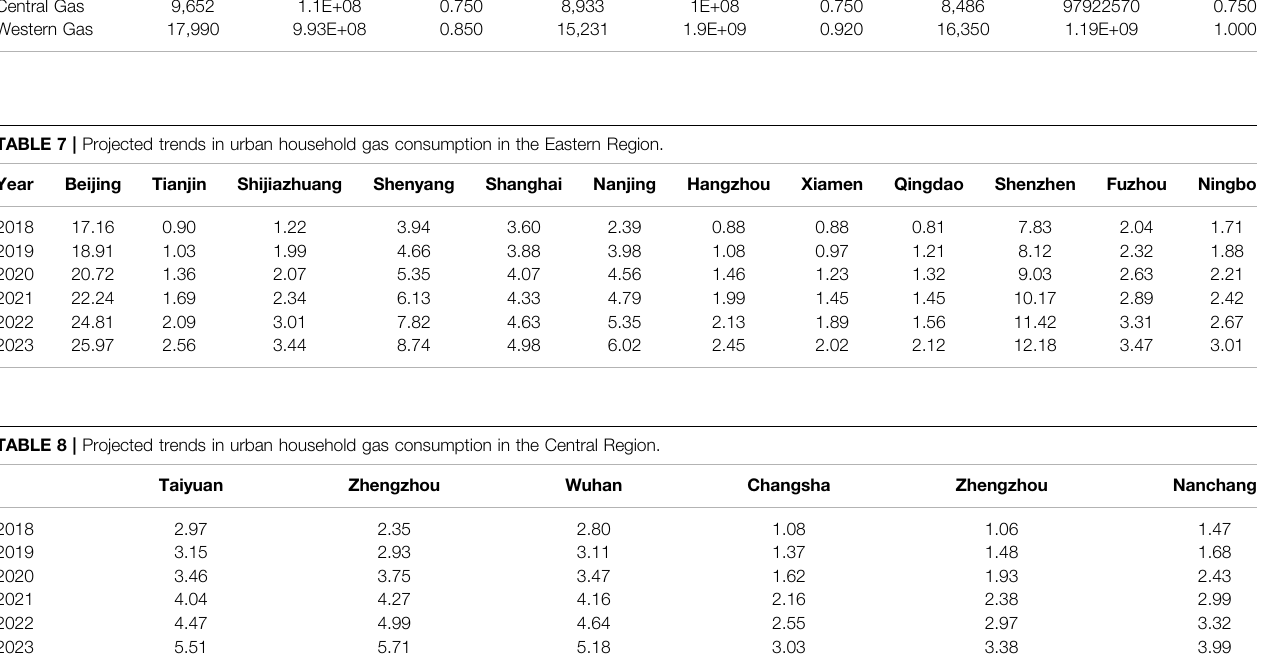
TABLE 6 | Comparison of prediction results between linear and non-linear prediction methods. Region Linear model (LR) Decision trees (GBDT) Support vector machines (SVR) MAE RMSE National Gas 20,417